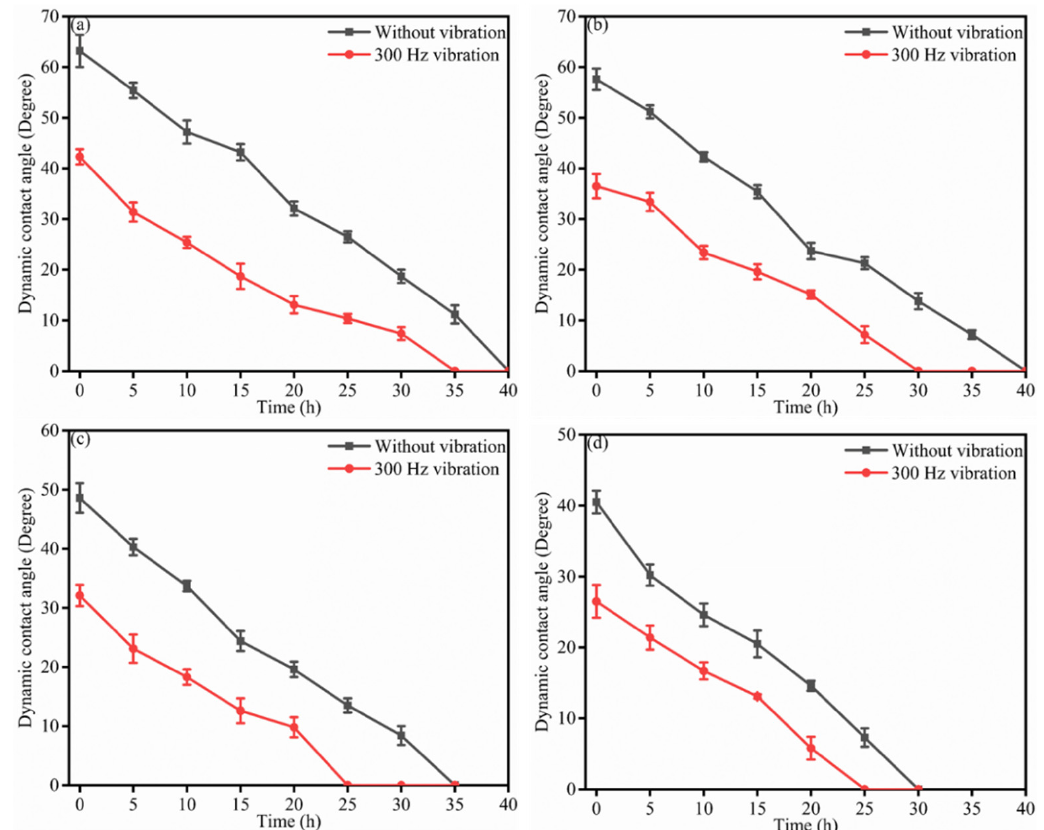
Figure 10. The gas/solid/water dynamic contact angles of sewage water drops onto the ( a ) iron casting; ( b ) steel; ( c ) PVC; ( d ) PE, with or without 300 Hz vibration.